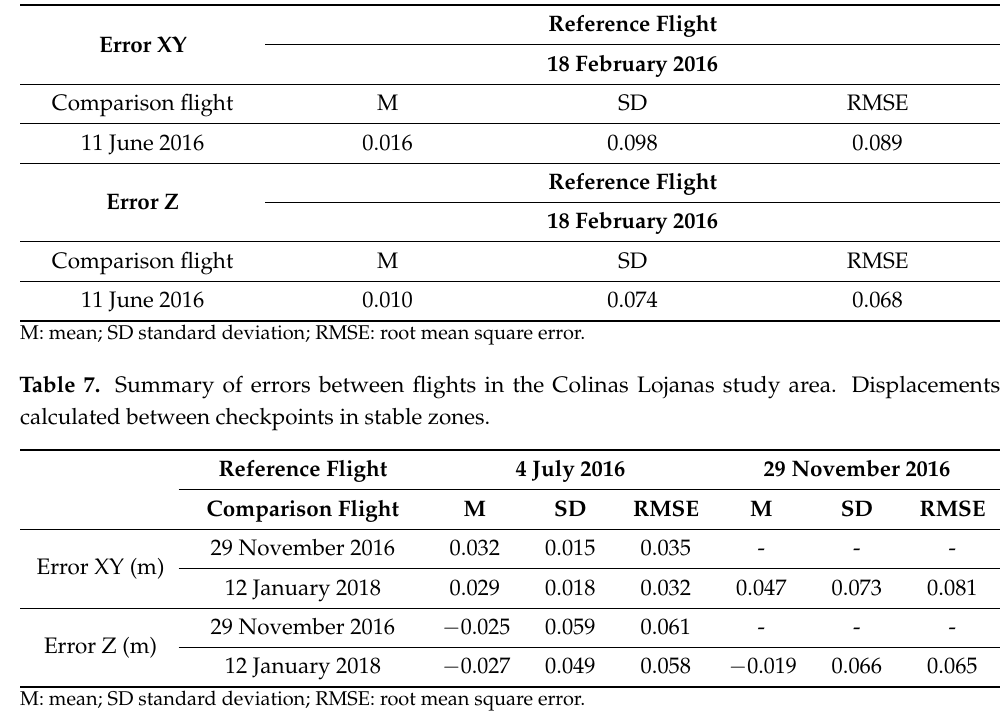
Table 6. Summary of errors between flights in the Victoria study area. Displacements calculated between checkpoints in stable zones.